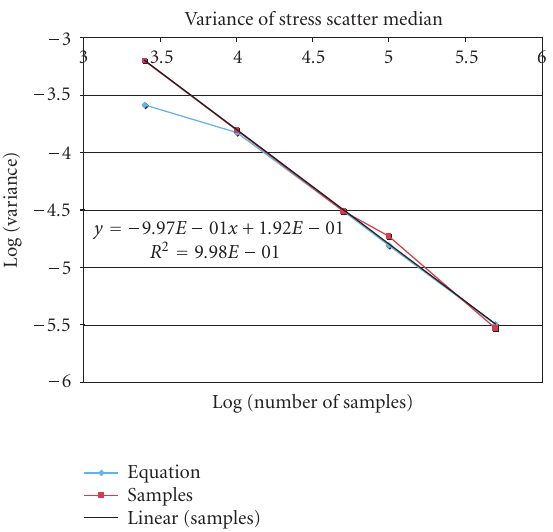
Figure 6: Variance of stress scatter median sensitivity estimate on log-log scale.